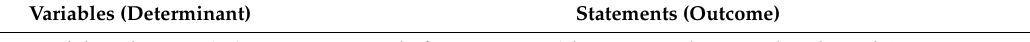
Table 4. Statistically significant regression results associating level of agreement with individual statements with local government type, indicating estimated coe ffi cients and standard errors (in parentheses) (see Table